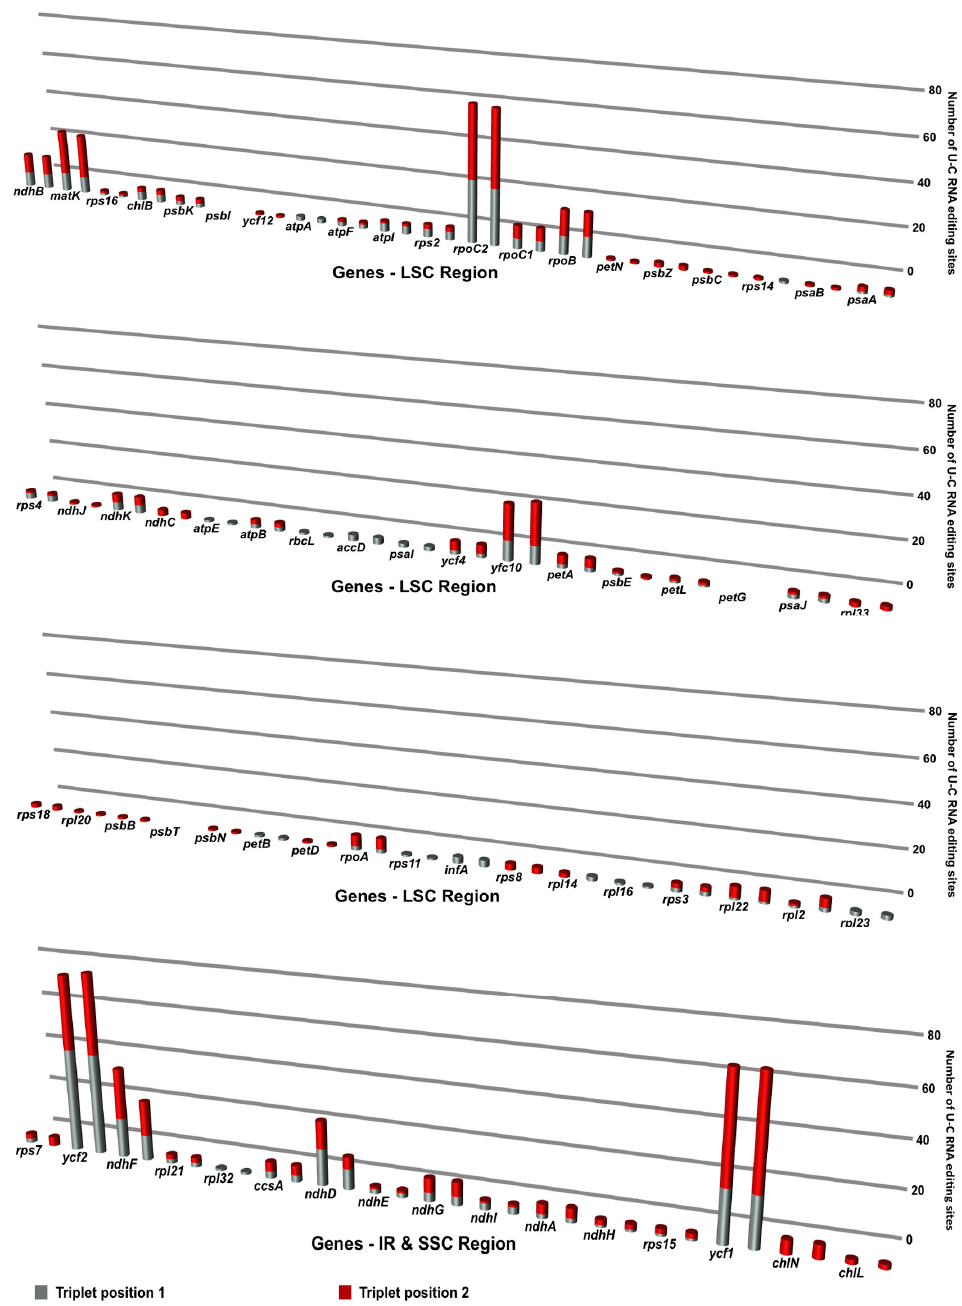
Figure 6. Triplet position and number of U-to-C RNA editing sites in plastid genes of C. falcatum and C. devexiscapulae were compared. Columns represent the protein-coding genes of C. falcatum and C. devexiscapulae , respectively. The gray cylindrical column indicates U-to-C RNA editing events that occurred in triplet position 1, whereas the red cylindrical column indicates U-to-C RNA editing events that occurred in triplet position 2.